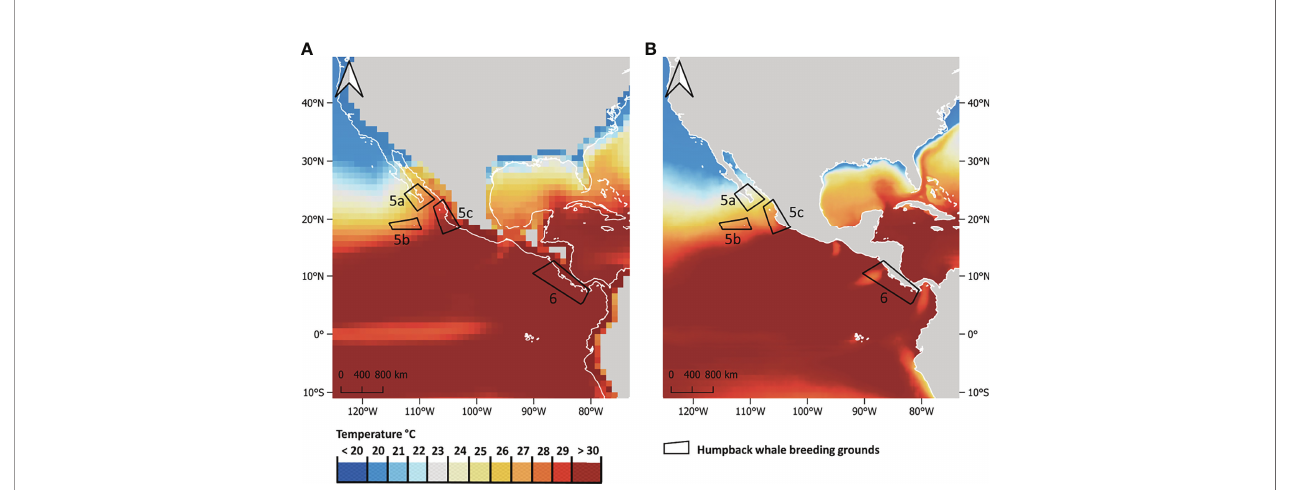
FIGURE 1 | Comparison of (A) non-downscaled mean CMIP6 SST data at a 1° (~100 km at the equator) resolution and (B) statistically downscaled CMIP6 SST data at a 0.05° (~5 km at the equator) resolution. SSTs projections shown are for the month of February, scenario SSP5-RCP8.5 by the year 2100. Boxes outline humpback whale DPS 5a (Mexico: Baja California), 5b (Mexico: Revillagigedos), 5c (Mexico: Mainland) and 6 (Central